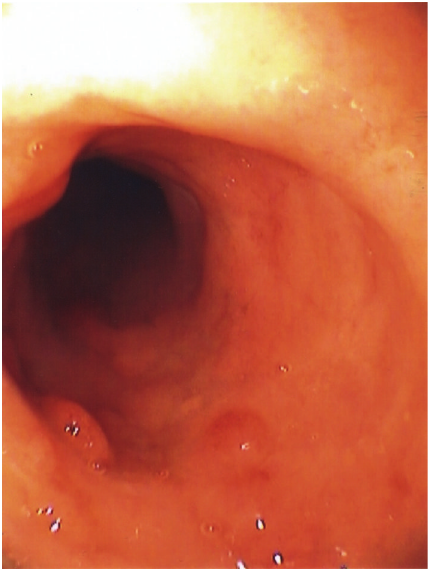
Figure 2: Colonoscopic view of a patient with eosinophilic colitis showing mild inflammatory changes, mucosal edema, patchy erythema, and loss of